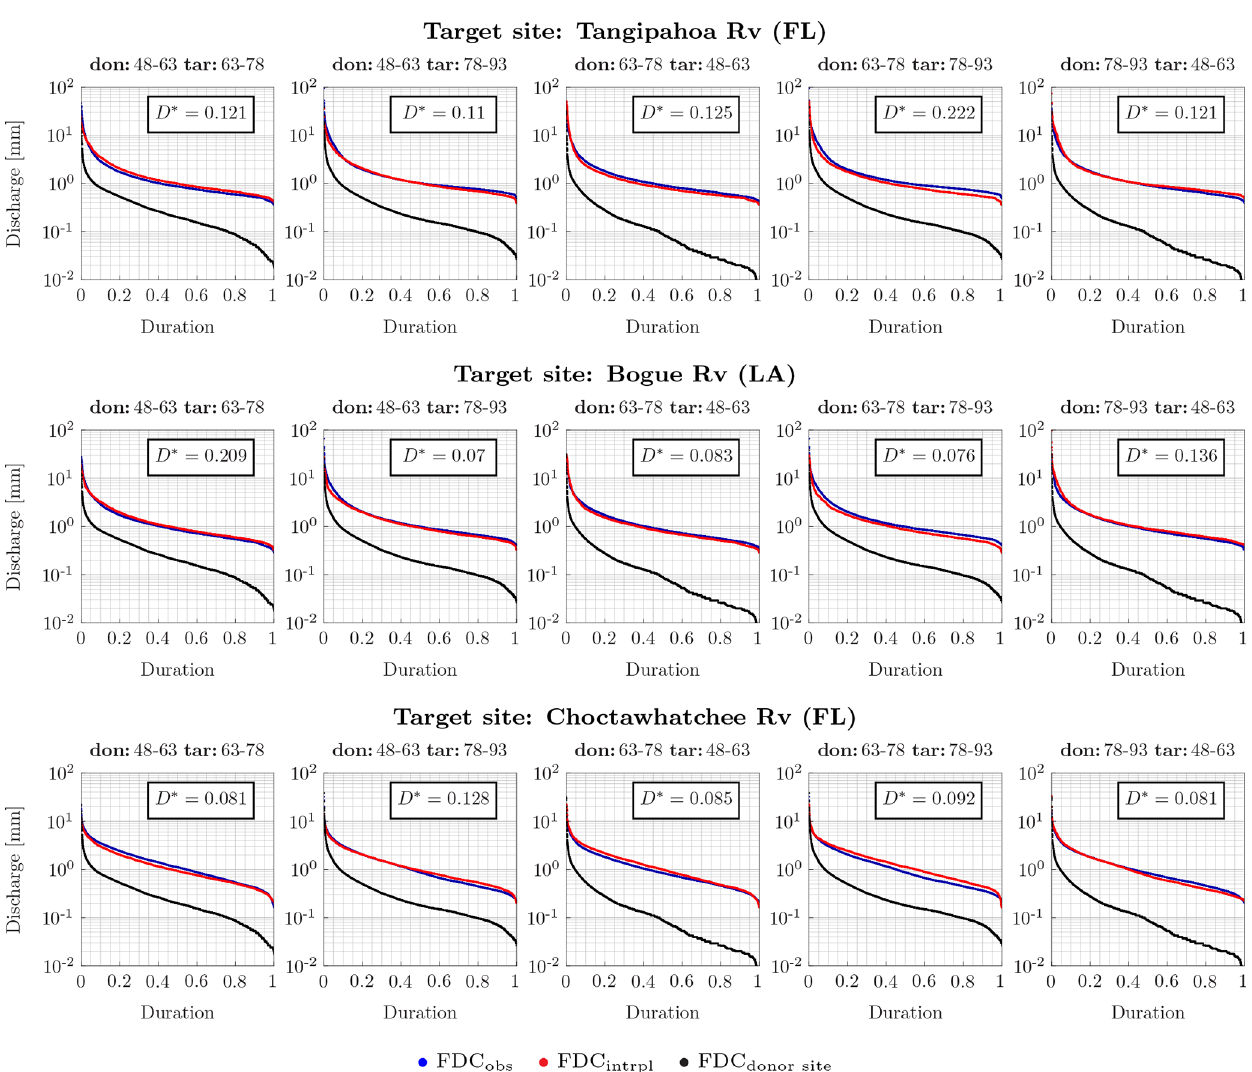
Figure 8. Interpolated FDC at Tangipahoa River (FL), Bogue River (LA) and Choctawhatchee River (FL), in the upper, middle and lower panels, respectively. The donor basin is Blanco River (TX). The donor and target years are periods of 15 years. The blue and red dots are observed and interpolated FDC, respectively, at the target basin during the target period; the black dots are the observed FDC at the donor basin during the target period. In each box the KS distance, D ∗ , is reported. The p value of D ∗ is always around